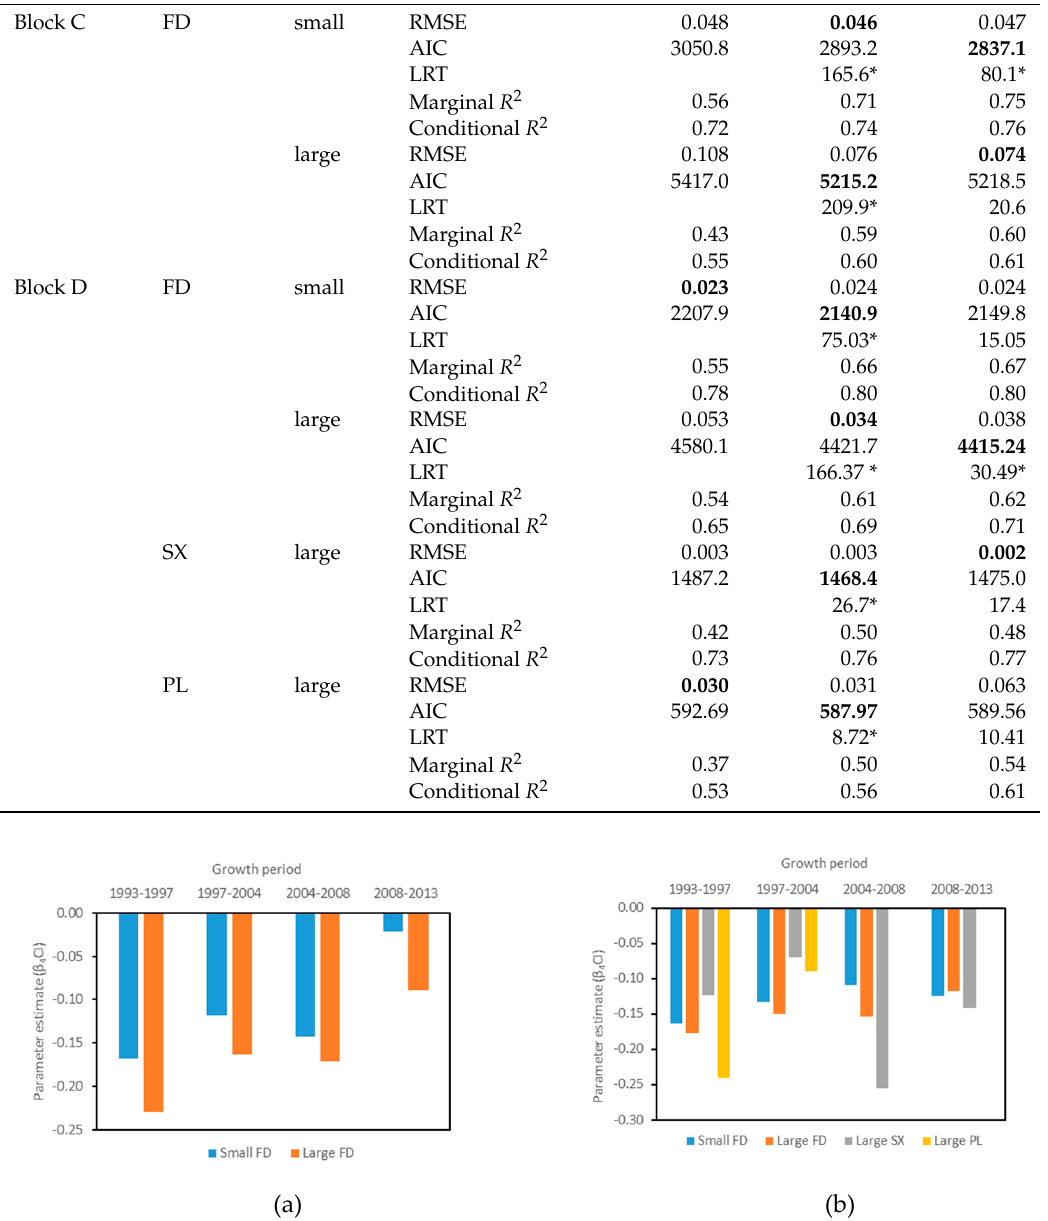
Figure 2. Parameter estimates for the Martin and Ek [30] competition index using Equation (8) for the four growth periods: ( a ) small (from 2.0 to 9.9 cm DBH as of 1993) and large ( ≥ 10.0 cm DBH as of 1993) FD as subject trees in Block C; ( b ) small and large FD and large SX and PL as subject trees in Block